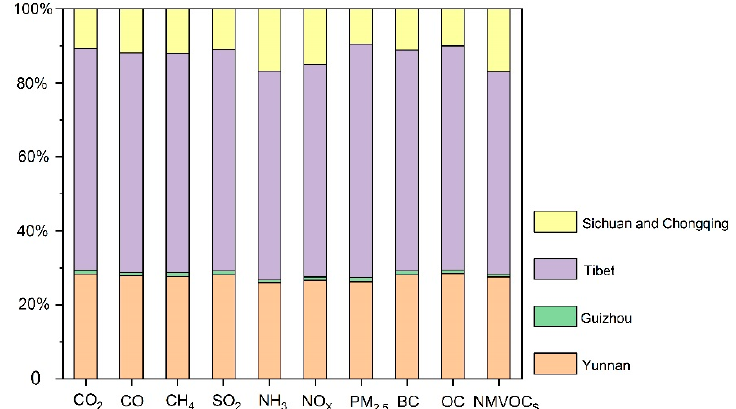
Figure 3. The pollutant emissions contribution of different provinces in southwest China in 2017.